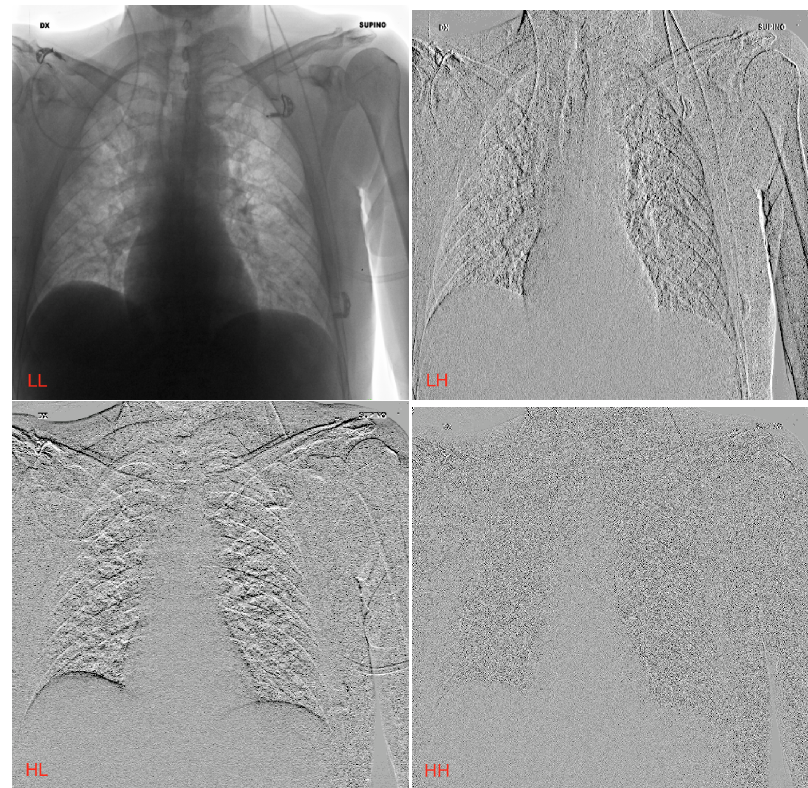
Figure 4. Four decompositions ( LL , LH , HL , and HH ) calculated by means of wavelets. In the example, the Haar kernel was used. example, the Haar kernel was